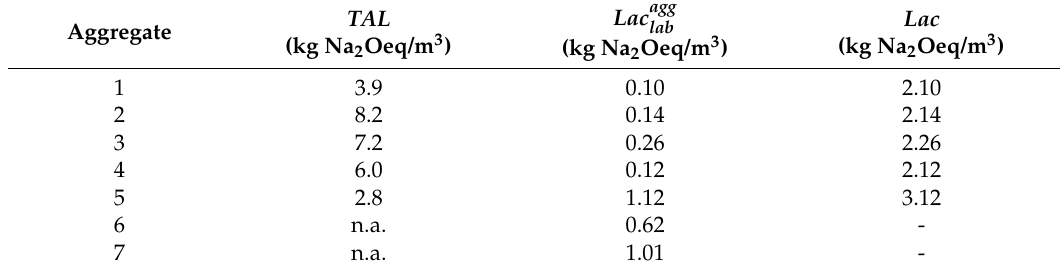
Table 8. Values of TAL , Lac agg and Lac for ASR prediction in Portland cement concrete dams. lab